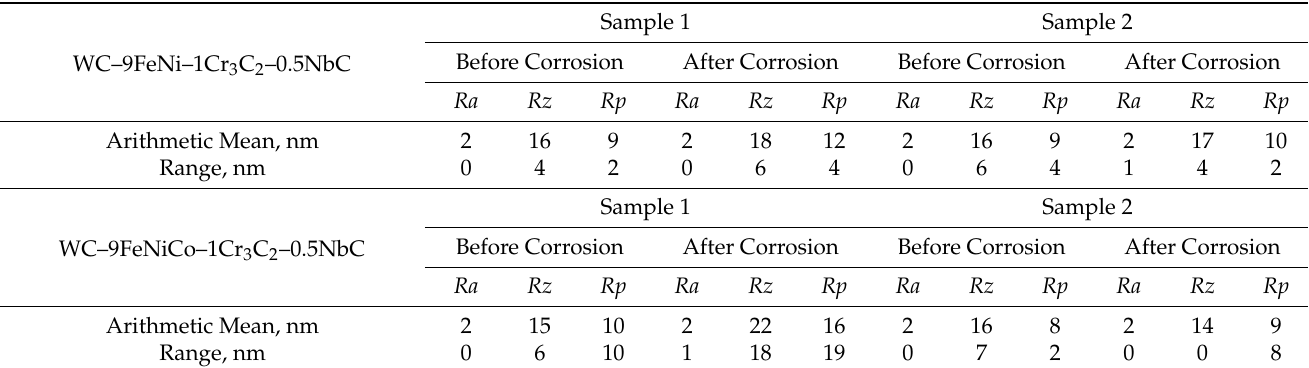
Table 6. Roughness measurement results before and after corrosion testing.